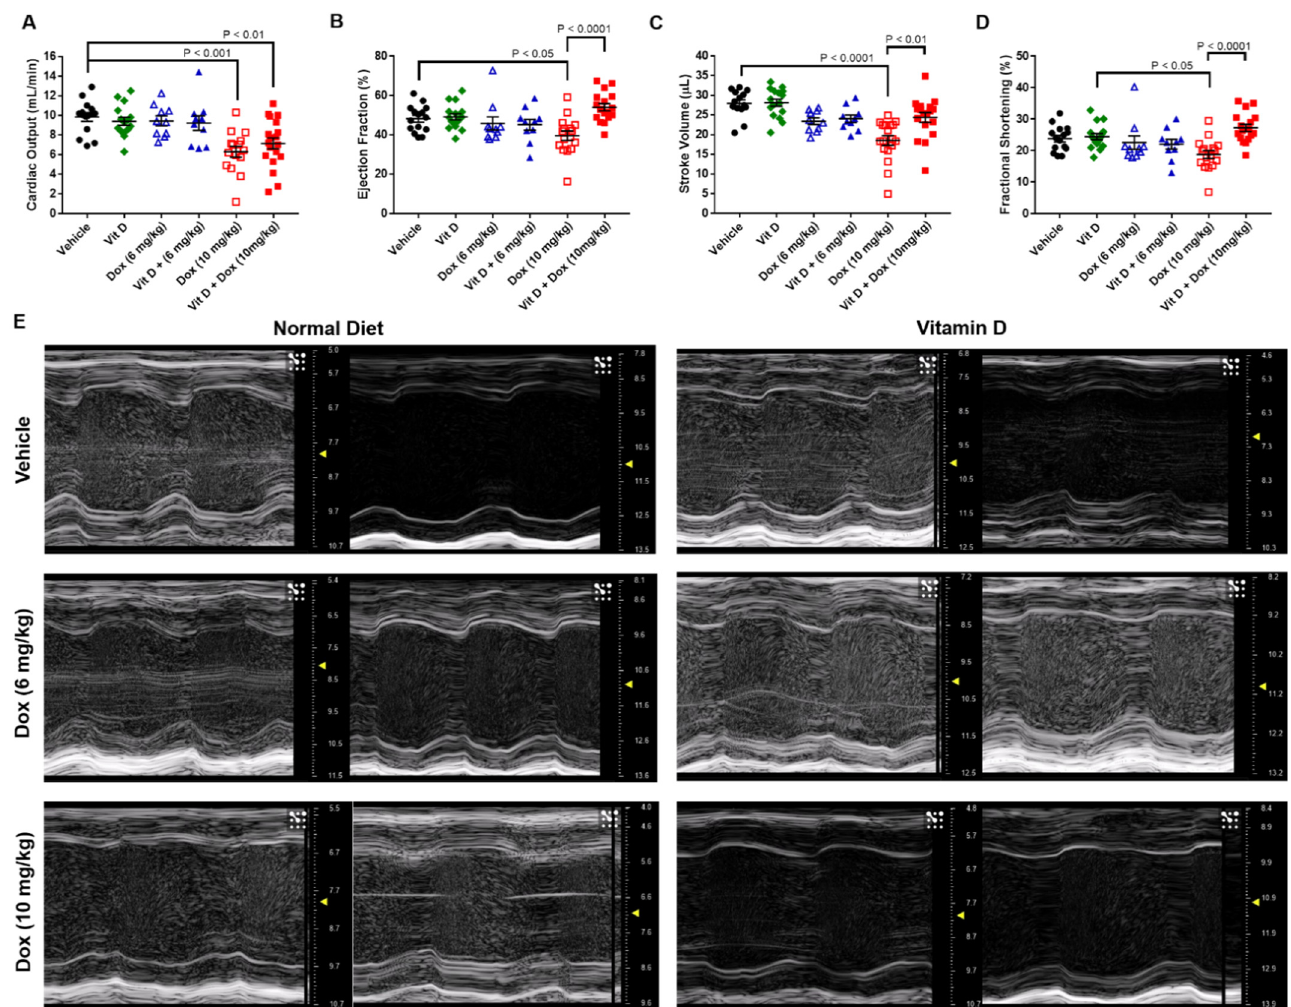
Figure 2. Transthoracic echocardiography of mice with vehicle or vitamin D-supplemented diet and doxorubicin treatment. ( A ) Cardiac output (mL/min). ( B ) Ejection fraction (%). ( C ) Stroke volume (µL). ( D ) Fractional shortening (%). Vehicle, 15 mice; Vit D, 16 mice; Dox (6 mg/kg) and Vit D + Dox (6 mg/kg), 10 mice each; Dox (10 mg/kg), 15 mice; Vit D + Dox (10 mg/kg), 19 mice. Videos were analyzed from day 18 for mice receiving Dox (6 mg/kg) or Vit D + Dox (6 mg/kg); all other mice were analyzed on day 15. ( E ) Still frame images extracted from echocardiography videos for two mice per group and representative of the mean of the ejection fraction.